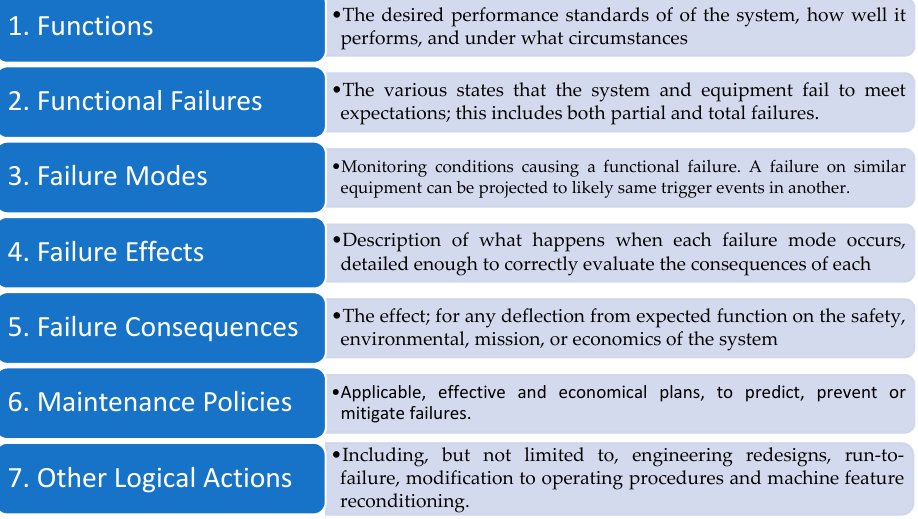
Figure 6. An overview of the items of the RCM process in sequence [24] .